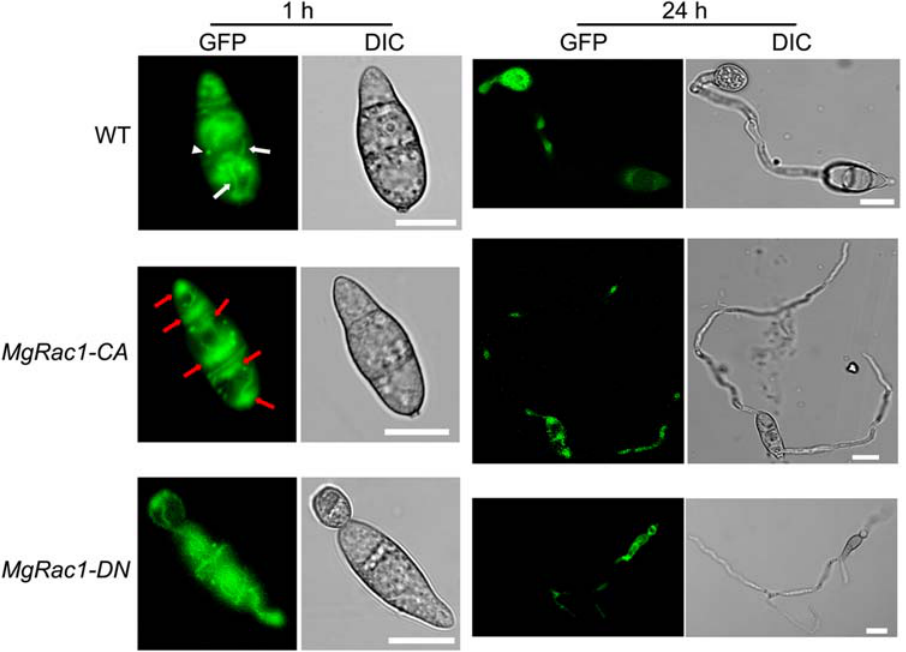
Figure 5. Cellular localization of tropomyosin-GFP in MgRac1-CAandMgRac1-DN mutants. Conidia expressing heterologous tropomyosin- GFP from WT (wild-type strain Guy11), MgRac1-CA , and MgRac1-DN were incubated on Gelbond films at 1 h and 24 h and observed by confocal fluorescence microscopy. Arrowhead indicates TpmA-GFP-labeled actin spot, white arrows indicate actin filaments, and red arrows indicate the areas where actin structures accumulate. Bar=10 m m.